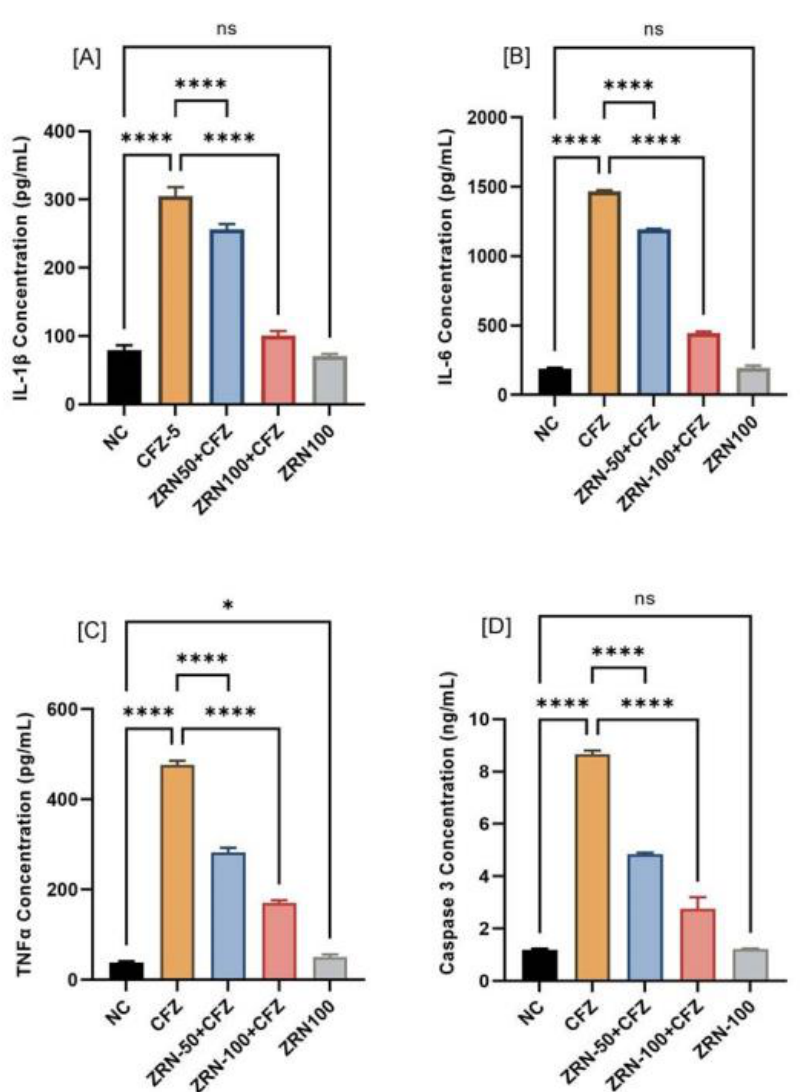
Figure 3. ( A – D ) The effects of zingerone on inflammatory and apoptotic markers such as IL-1 β , IL-6, TNF α , and caspase-3 after CFZ administration in rats. Data are represented as the mean ± sd ( n = 8). The concentrations of IL-1 β , IL-6, TNF α , and caspase-3 were increased significantly (**** p < 0.0001) in CFZ as compared to NC. Pretreatment of zingerone also showed significantly (**** p < 0.0001) decreased IL-1 β , IL-6, TNF α , and caspase-3 content in ZRN50 + CFZ and ZRN100 + CFZ, as compared to CFZ. There were no significant changes seen in zingerone alone treatment (ns p > 0.05) as compared to NC, except TNF α . Abbreviations: NC: Normal control, CFZ: Carfilzomib, ZRN: